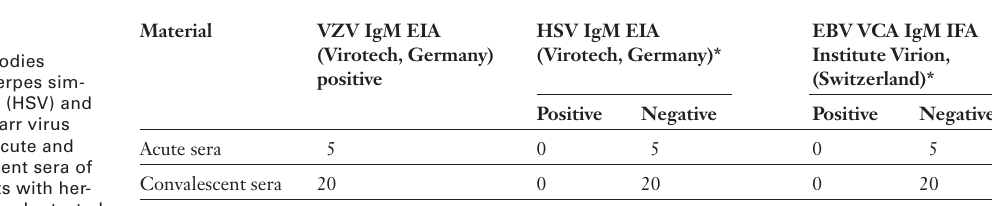
Performance of PCR test for the detection of varicella-zoster virus DNA from patient serum in the course of herpes zoster.